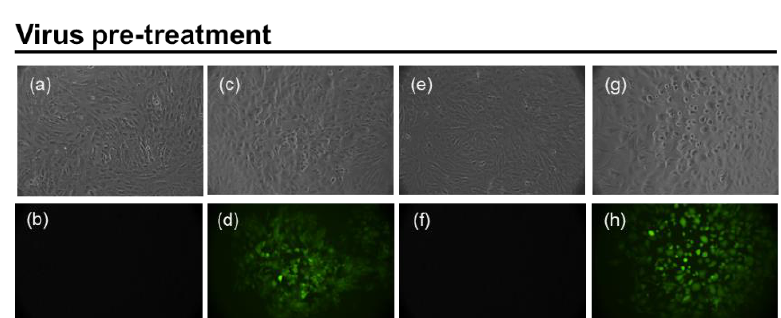
Figure 3. Antiviral activity against HSV-1-GFP. Evaluation of GFP expression in Vero cells infected by HSV-1 at 48 h post infection in co-treatment ( A ) and virus pre-treatment ( B ) assays. In the upper part of each panel, there are images visualized in RGB and, on the contrary, fuorescent images are reported below. ( a ) and ( b ) reported not infected and not treated cells; ( c ) and ( d ) indicated only infected cells; No plaques were present in ( e ) and ( f ) when cells were stimulated with AR-23 at 1.5 µM and 0.78 µM, in co-treatment ( A ) and virus pre-treatment ( B ); ( g ) and ( h ) reported plaques in cells treated with 0.39 µM of peptide in both the assays.